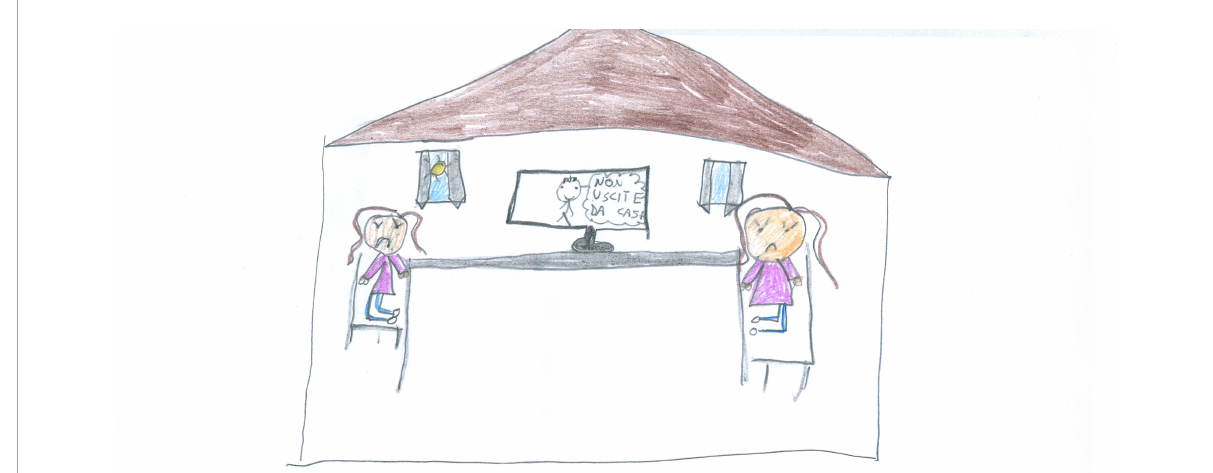
FIGURE19 An uncommon example of PAIR’s negative emotions; TV says: do not go outside (PS, Female, 9 years).